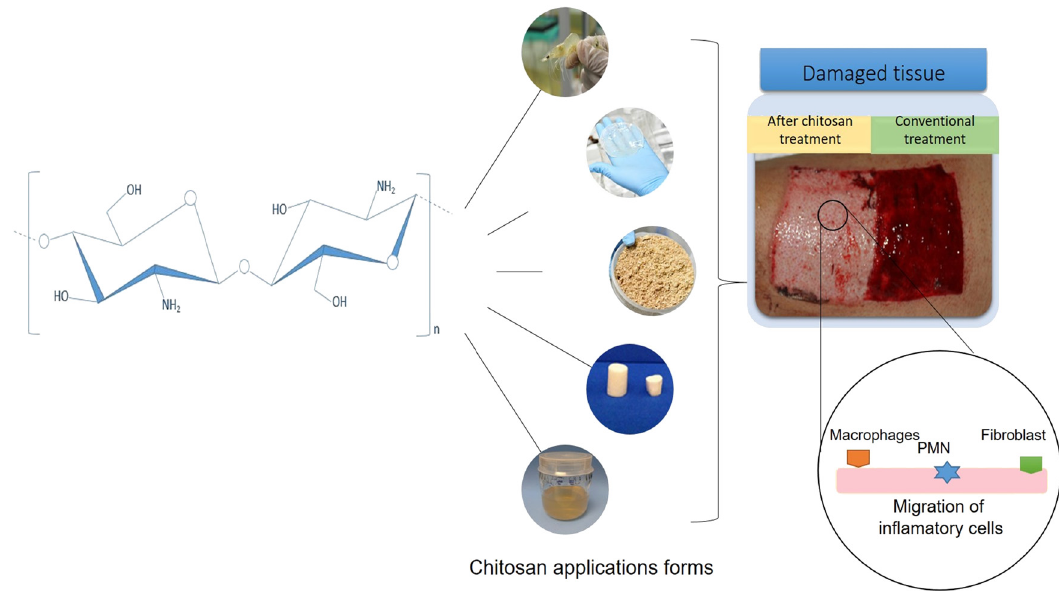
Figure 2: Graphic representation of the application of chitosan in wound